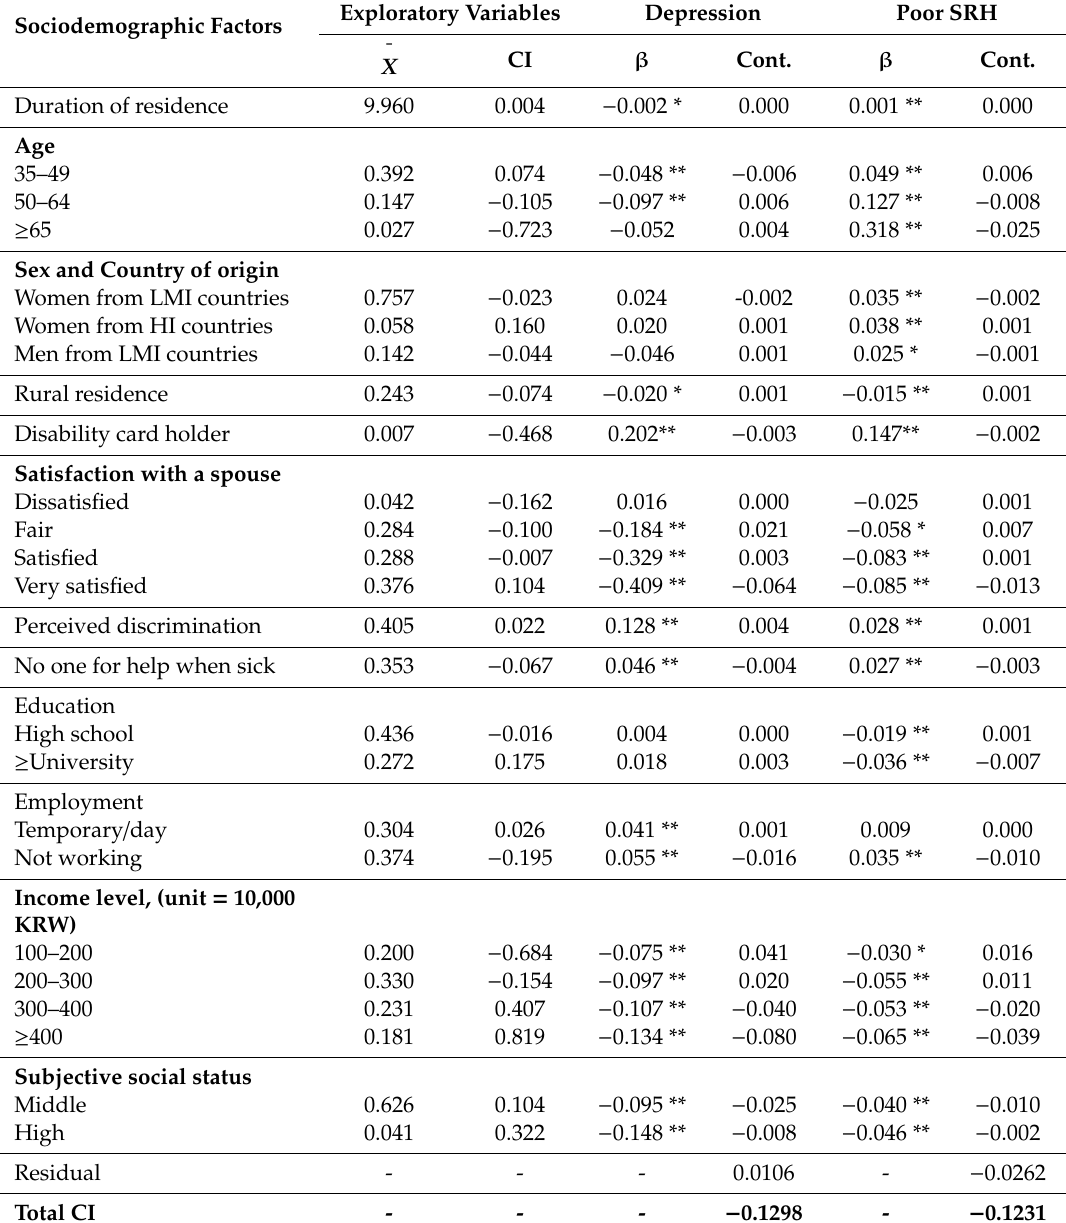
Table 3. Results of the decomposition analysis for the income-related inequality in self-reported depression and poor